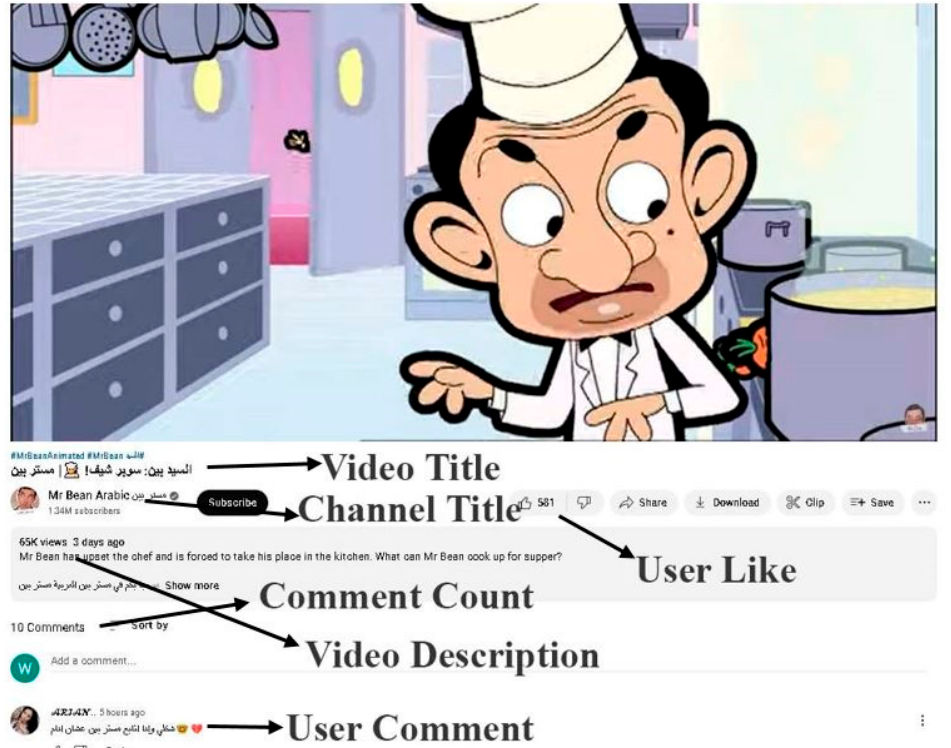
Figure 7. Example of YouTube video meta-data.